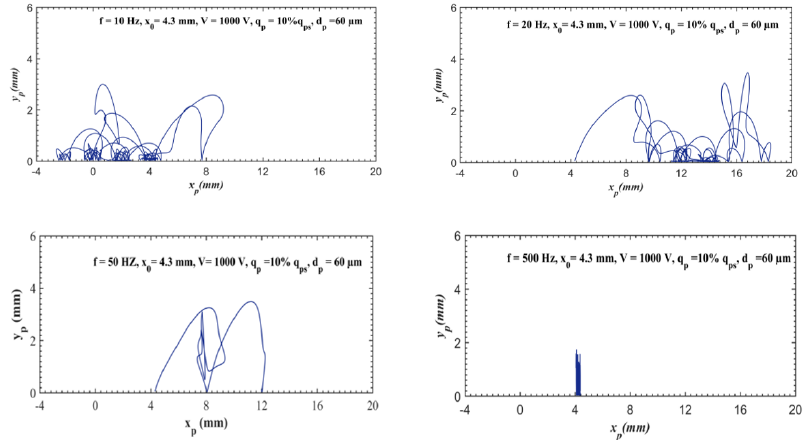
Figure 8. Particle trajectories for different frequency values (10 Hz, 20 Hz, 50 Hz, and 500 Hz). Con- ditions : 𝑉 = 1000 V, 𝑑 𝑝 = 60 µm, 𝑞 𝑝 = 10% 𝑞 𝑝𝑠 , 𝑡 = 500 ms. Conditions: V = 1000 V, d p = 60 µ m, q p = 10% q ps , t = 500